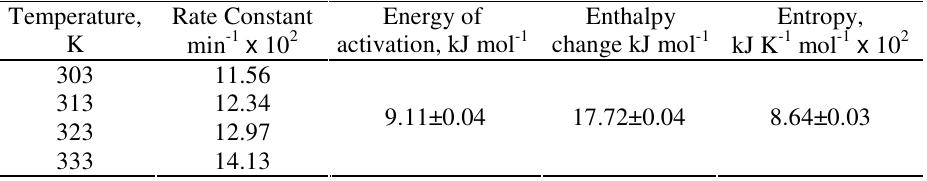
Table 1. Thermodynamic parameter for adsorption of Ce(III) ions on local clay